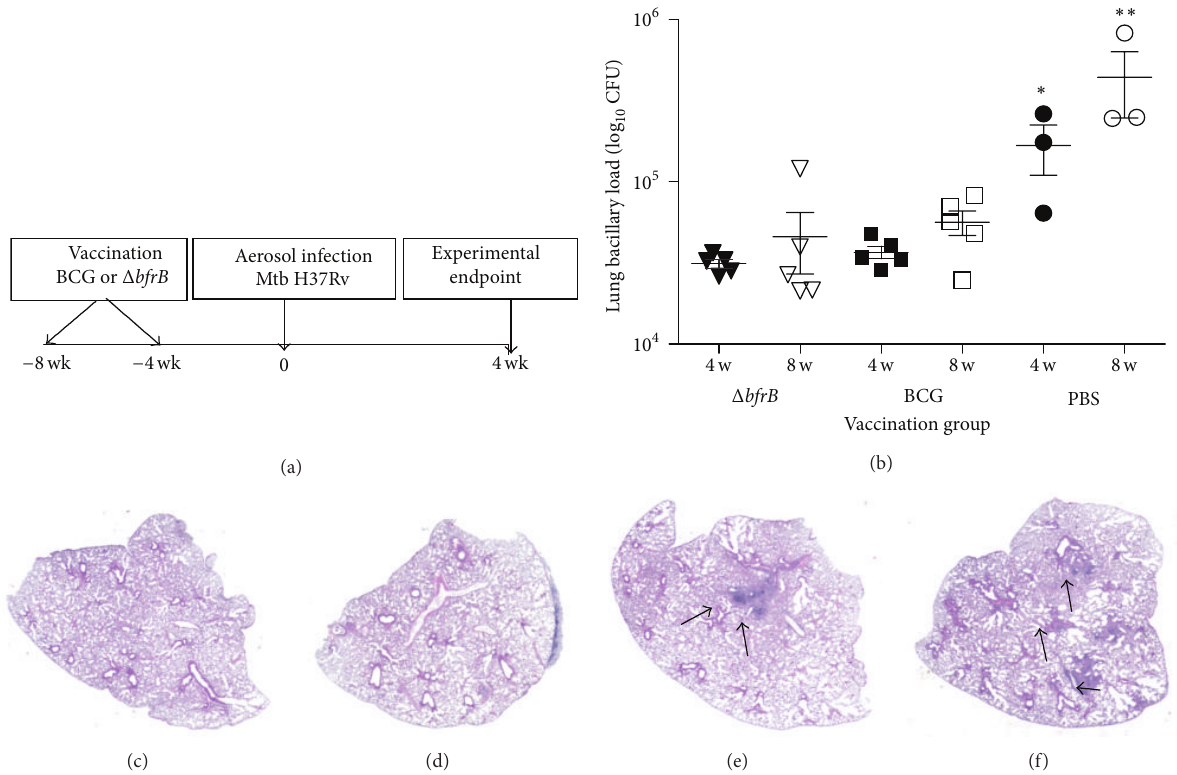
Figure 1: Experimental design, lung bacillary burden, and gross pathology of vaccinated and uninfected or Mtb-infected mice. (a) Schema of the mice vaccination schedule and Mtb infection experiment. (b) Lung bacillary load in mice infected with virulent Mtb H37Rv after vaccination with PBS (sham) or BCG or Δ bfrB for 4 ( ∗ 𝑃 = 0.033 ) or 8 weeks ( ∗∗ 𝑃 = 0.035 ). Gross lung pathology of vaccinated and uninfected or Mtb-infected-mice. (c) H&E stained lung section of BCG vaccinated (for 8 weeks) and uninfected mice. (d) H&E stained lung section of Δ bfrB vaccinated (for 8 weeks) and uninfected mice. (e) H&E stained lung section of BCG vaccinated (for 8 weeks) and Mtb-infected (for 4 weeks) mice. The arrows in (e) show a multifocal, coalescent granuloma. (f) H&E stained lung section of Δ bfrB vaccinated (for 8 weeks) and Mtb-infected (for 4 weeks) mice. The arrows in (f) show multiple, small granulomas.